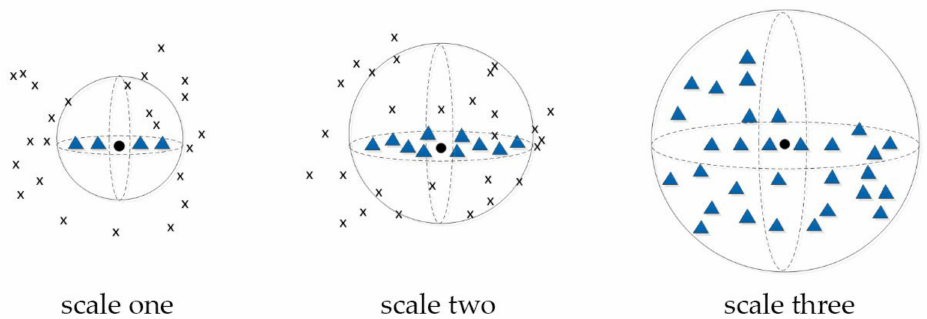
Figure 2. Neighborhood of point cloud at different